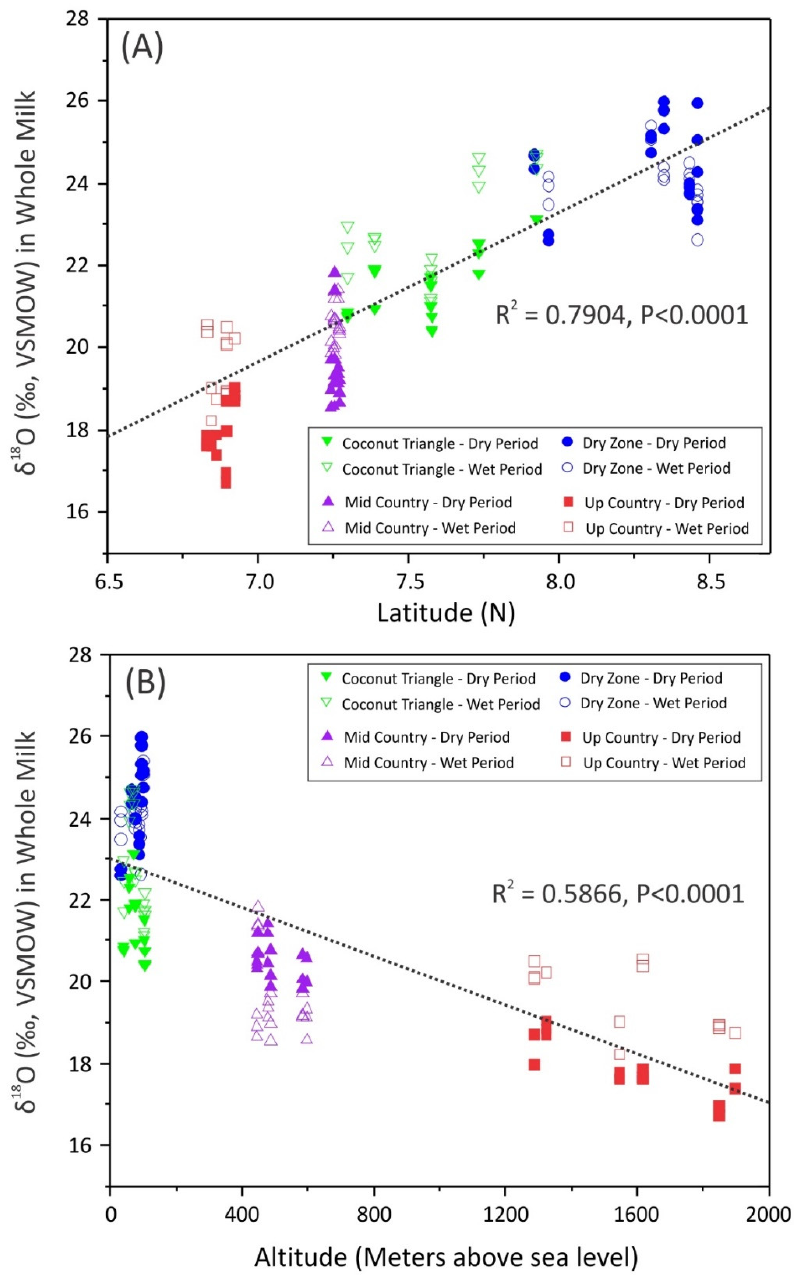
Figure 3. Correlation between δ 18 O values of whole milk samples collected and farms at different altitudes and latitudes. ( A ) Variation of δ 18 O in whole milk with latitude, ( B ) variation of δ 18 O in whole milk with altitude.